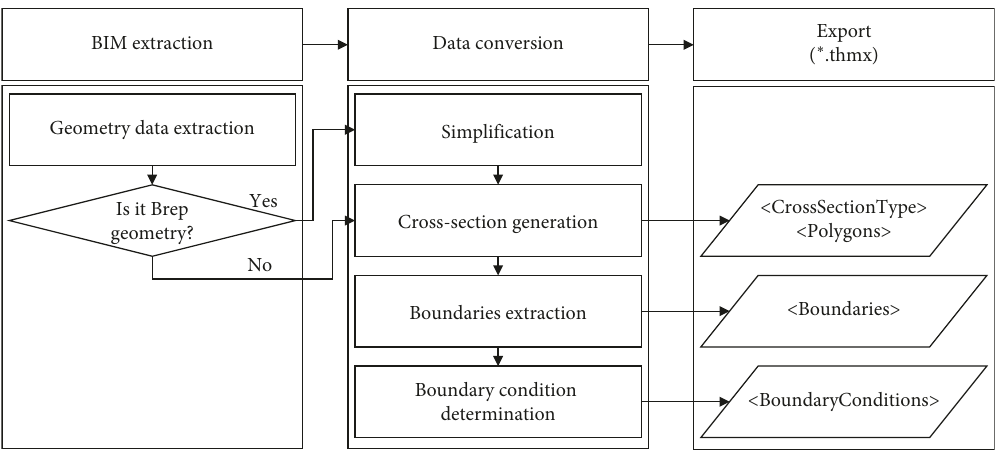
Figure 1: BIM-based framework for window thermal performance